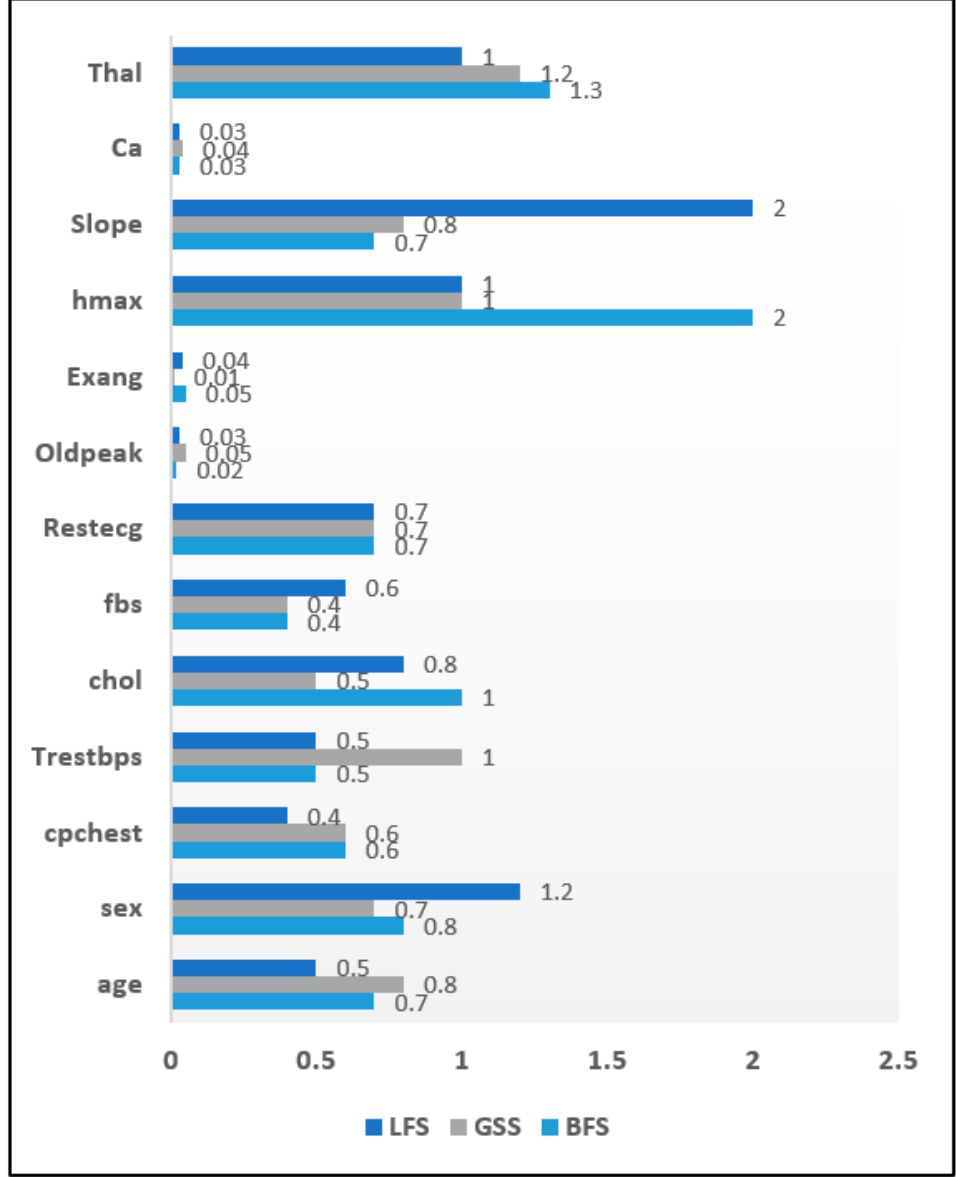
Figure 9. Attribute Significance Graph for the Heart disease dataset with Wrappers.